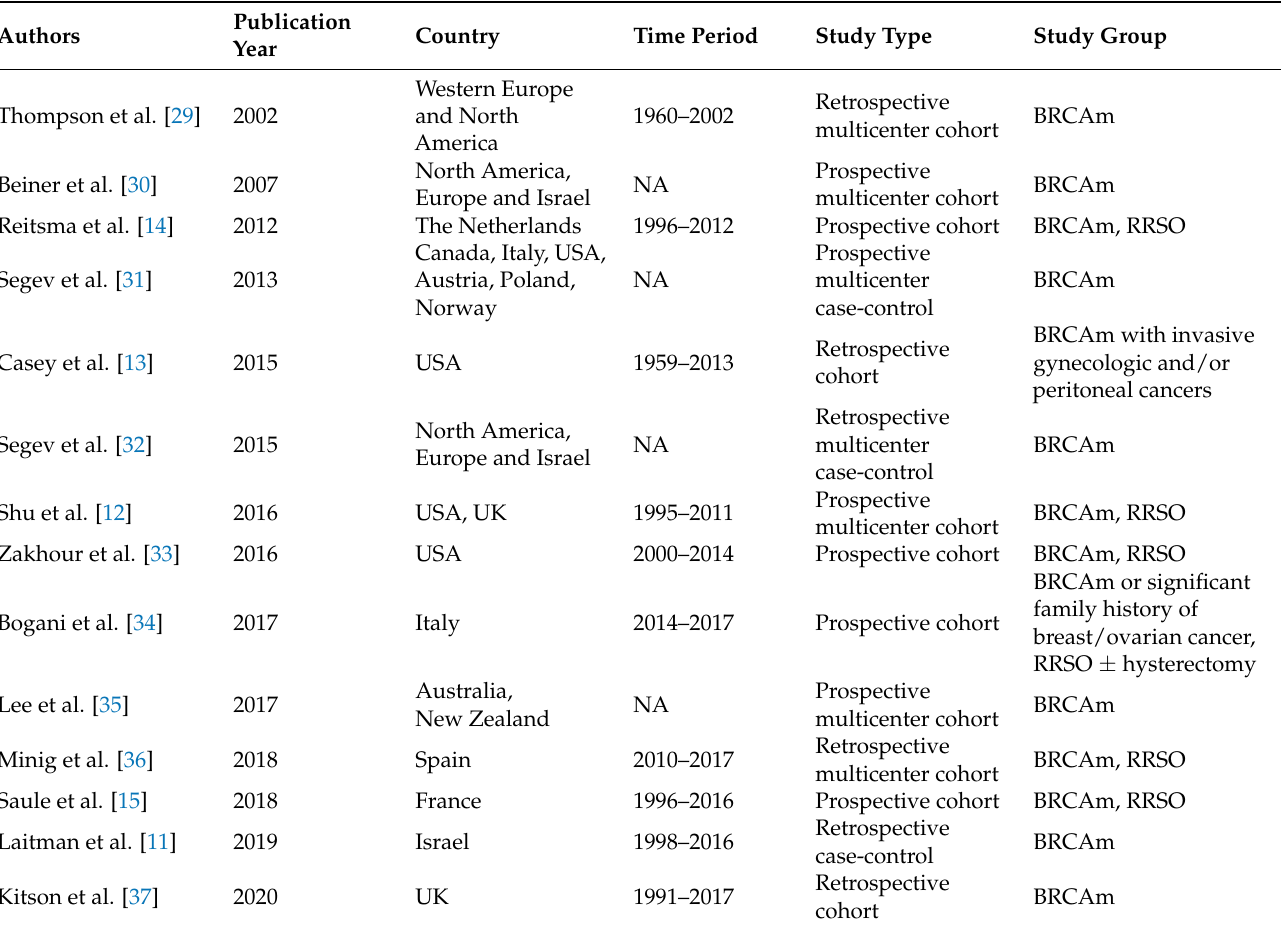
Table 2. Characteristics of the included studies on the incidence of endometrial cancer in BRCAm